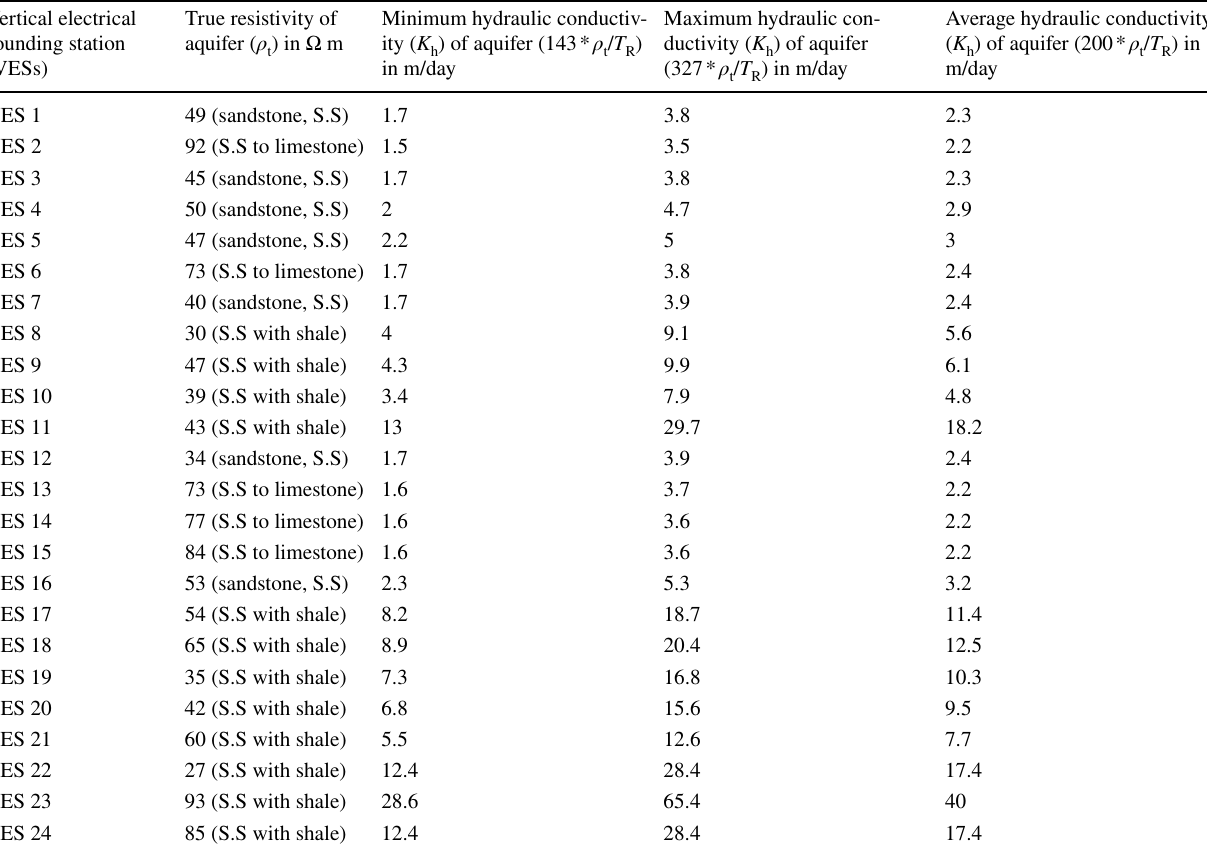
K h ) in m/day of the aquifer